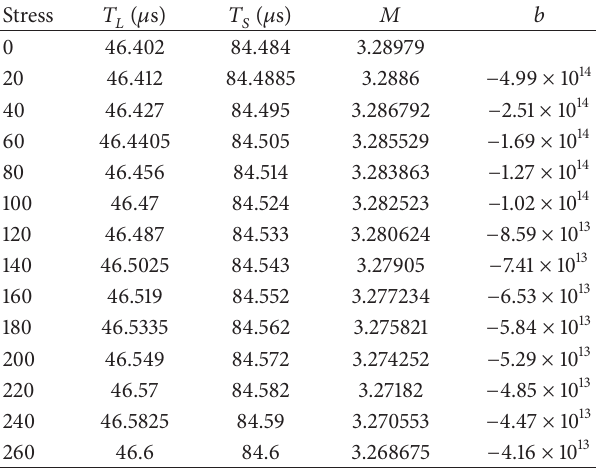
Table 3: Axial tensile stress measurement results for a low-carbon 8.8 steel